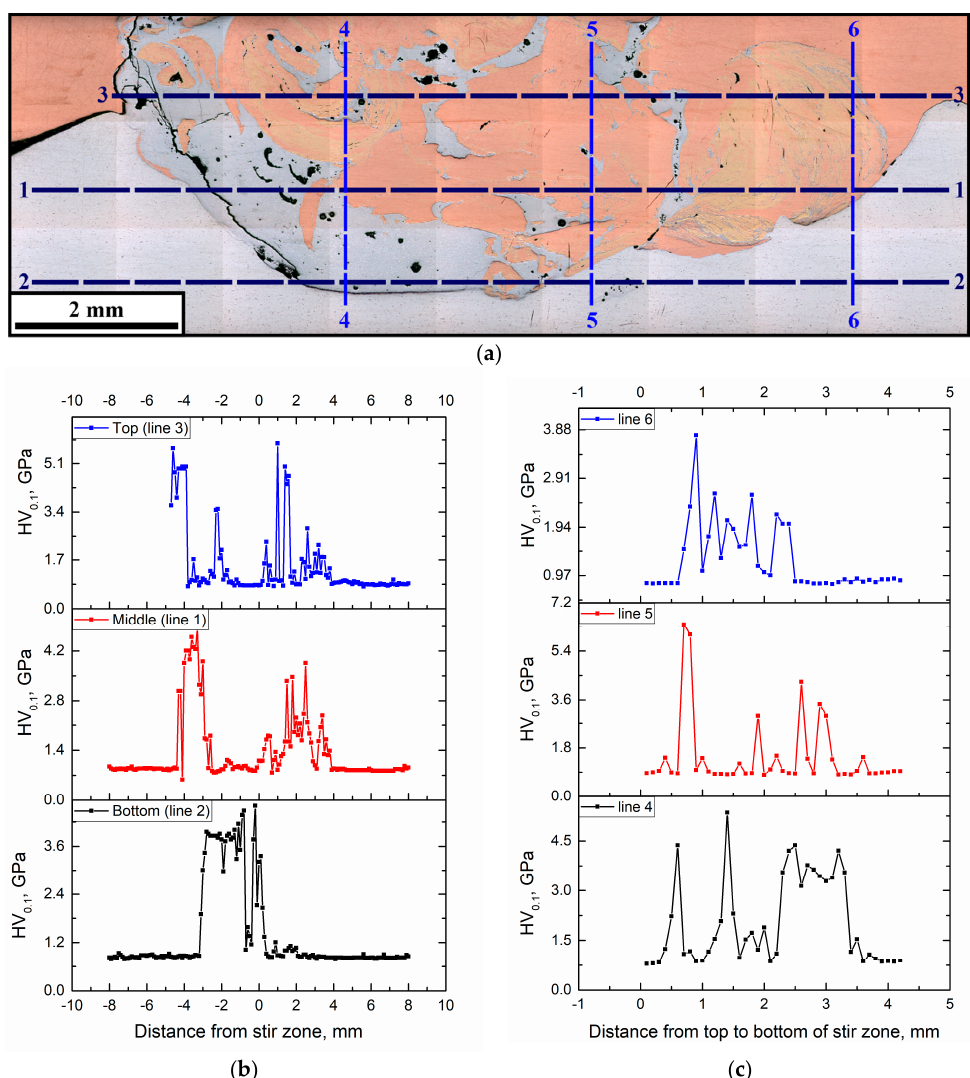
Figure 7. Microhardness profile measurement lines ( a ) and microhardness profiles along horizontal (1, 2, 3) ( b ) and vertical (4, 5, 6) directions ( c ).